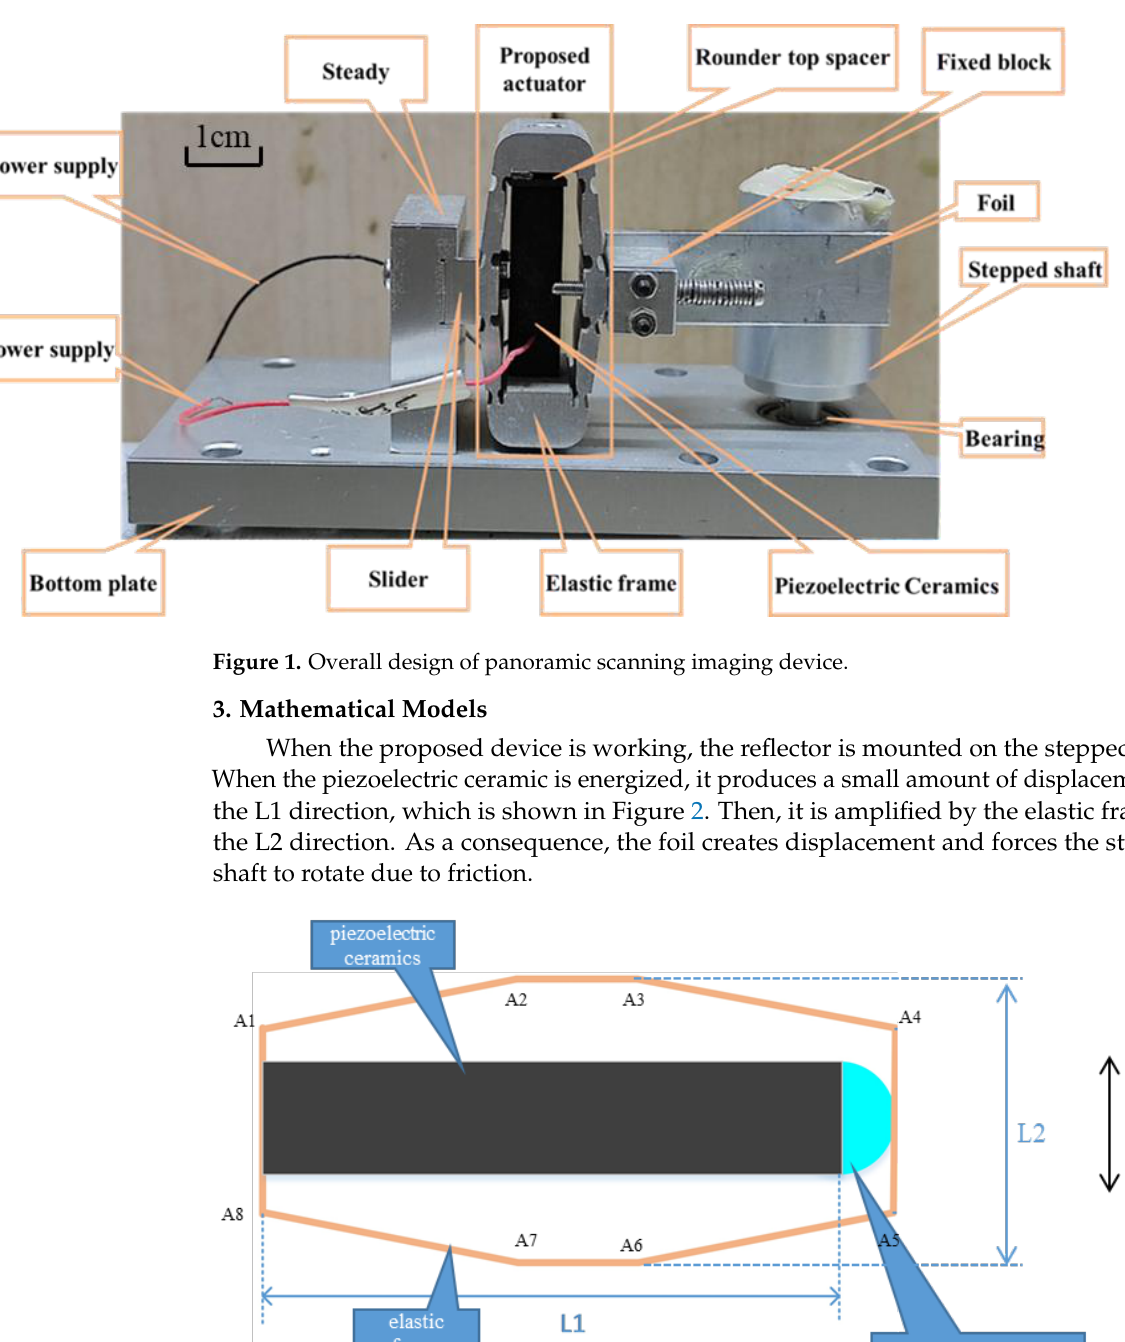
A1A2A3 = ∠ A8A7A6 = ∠ A7A6A5 = ∠ A2A3A4 = θ ; when a certain voltage is applied